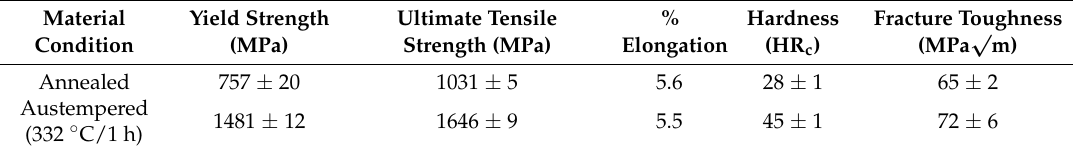
Table 3. Mechanical Properties of AISI 4140 Alloy.